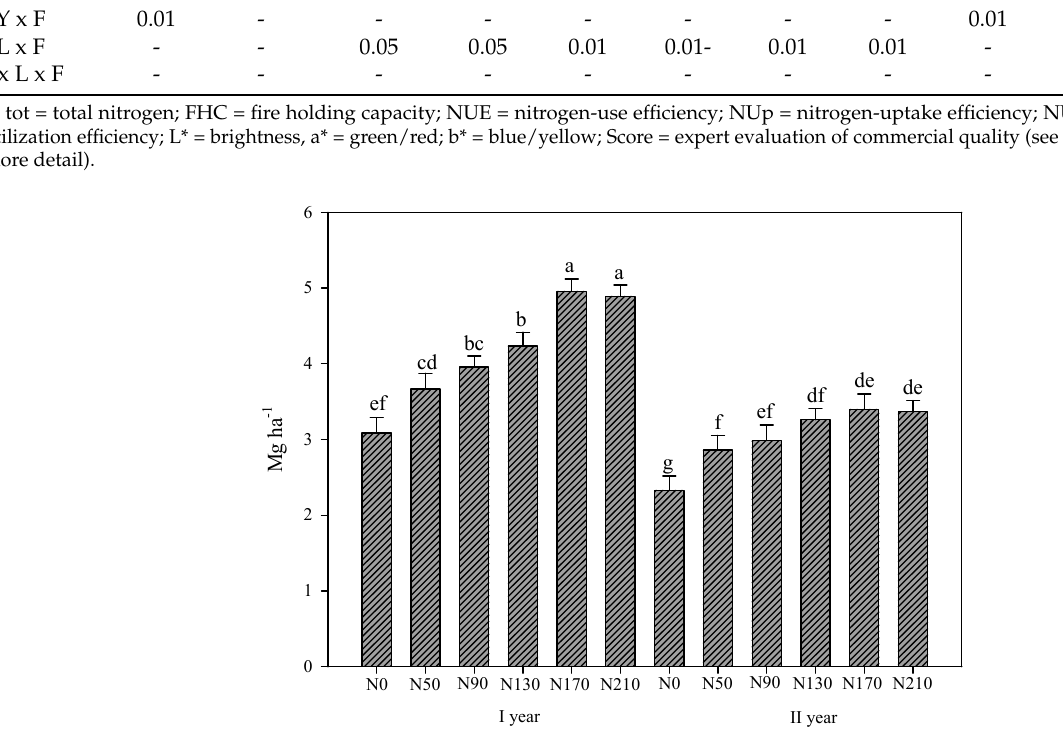
Figure 2. The effect of Years x N fertilization rates on yield of cured leaves (Mg ha − 1 ). Different letters indicate significant differences according to Duncan’s test ( p < 0.05).